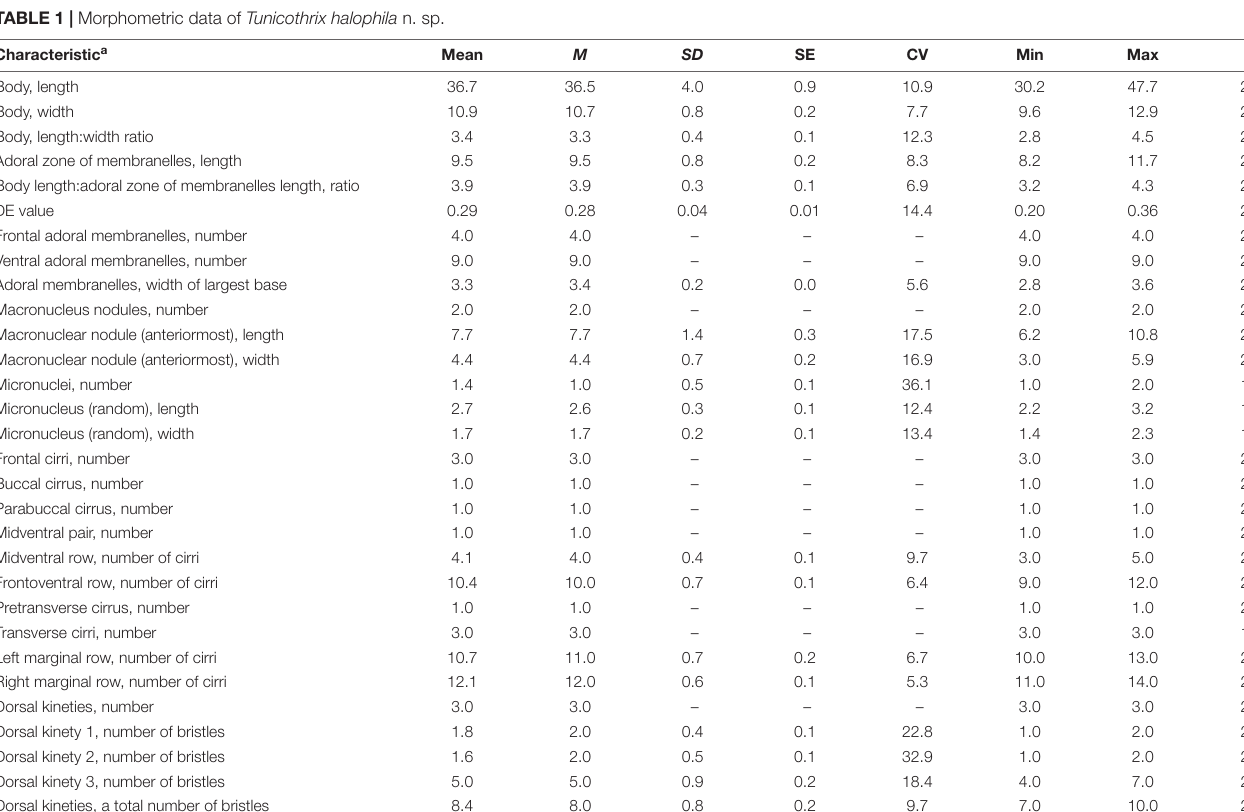
FIGURE 5 | Tunicothrix halophila n. sp. in vivo (A,B) and after protargol impregnation (C–E) . Arrows denote the alveolar layer-like structure observed in only few cells. TABLE 1 | Morphometric data of Tunicothrix halophila n.